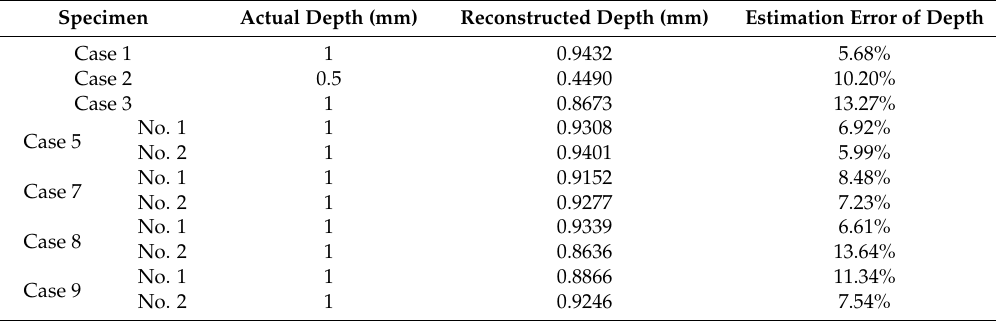
Table 7. The depth evaluations of Case 1 to Case 3, Case 5, Case 7, Case 8, and Case 9.